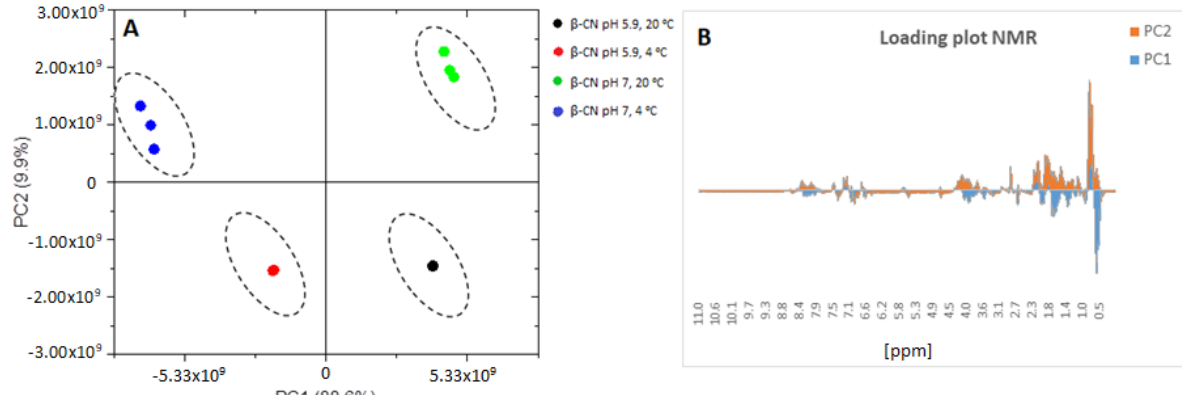
Figure 3. Principal components score plot ( A ) and loading plot ( B ) of β‐ casein of the NMR spectra in where β‐ casein at pH 5.9 and temperature of 20 °C (black), β‐ casein at pH 5.9 and temperature of 4 °C (red), β‐ casein at pH 7.0 and temperature of 20 °C (green) and β‐ casein at pH 7.0 and temperature of 4 °C (blue) are in ( A ) and PC1 (blue) and PC2 (orange) are in ( B ).